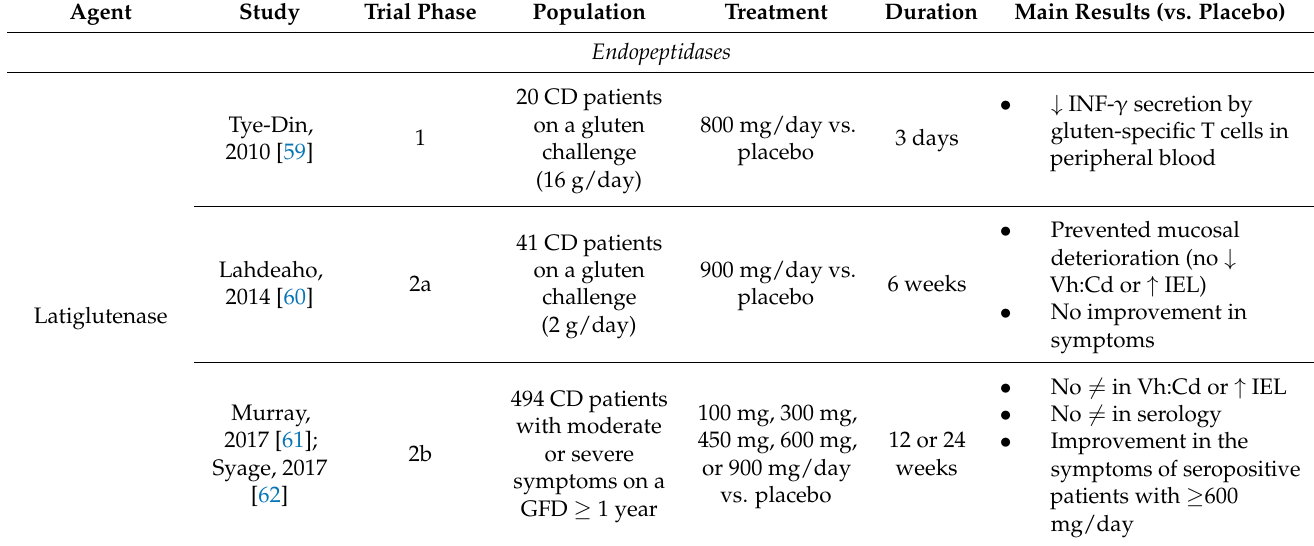
Table 1. Relevant clinical trials on agents that block immunogenic gluten